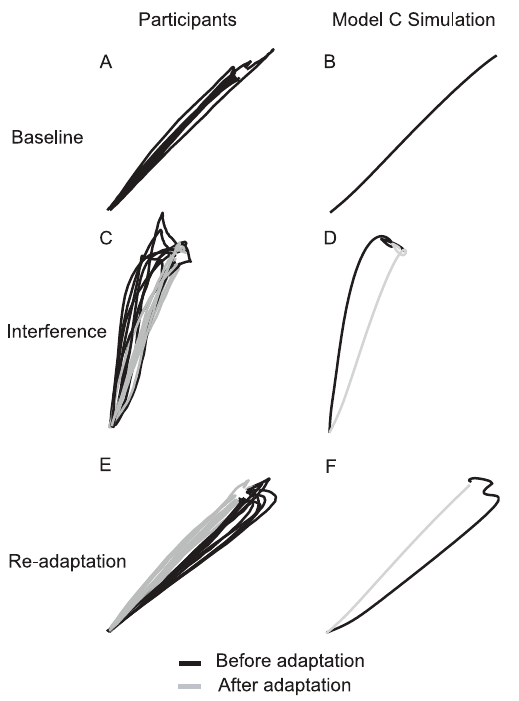
Figure 6. Trajectories of participants along with trajectories from the simulation of model C. The trajectories are taken from Experiment 3. The participants plot contains the trajectories from all ten participants for that particular trial. A , C , and E are from participants. B , D , and F are from simulations. A and B are one of the baseline trajectories. C and D are from the interference state. E and F are from the readaptation state. In figures C – F , the black lines are from the first trial of the state, and the grey lines are from the last trial of the